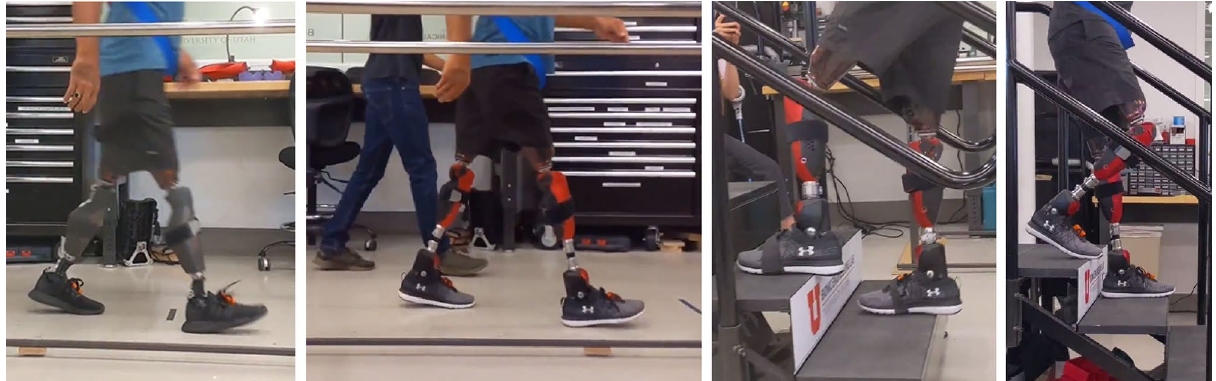
Figure 4. The passive and powered prostheses donned by the participant. From left to right, the images show the participant walking with his prescribed prostheses, walking with the powered prostheses,